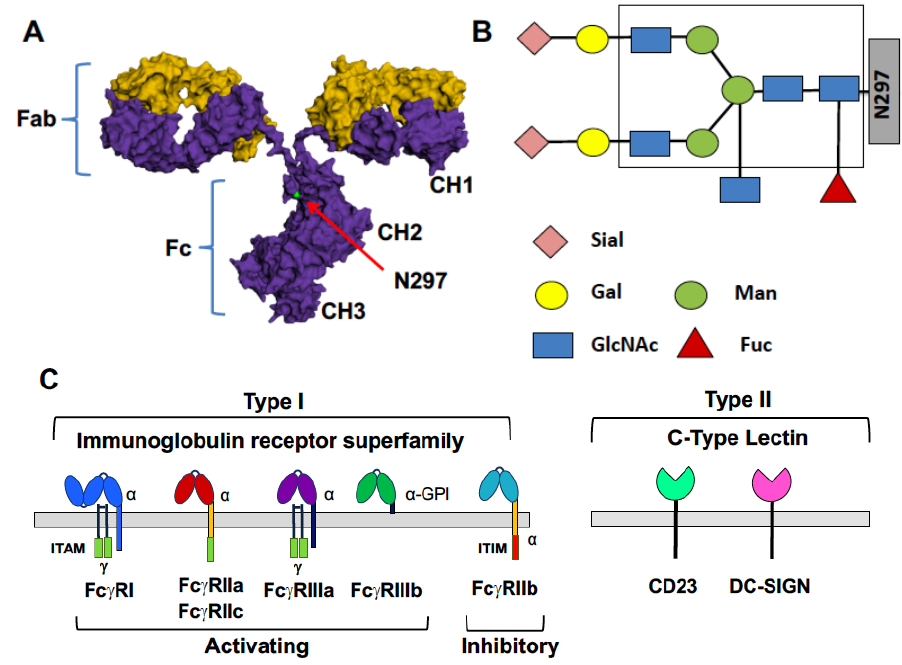
Figure 1. IgG antibodies and their receptors. ( A ) The structure of IgG molecules is composed of two identical heavy (purple) and light chains (yellow). Heavy and light chains combine to form Fab domains which bind antigen. The paired CH2 and CH3 domains of heavy chains form the IgG Fc domain. The structure of the Fc domain is dictated by IgG subclass and composition of the Fc glycan, located at N297 within the CH2; Fc structure, in turn, determines interactions with FcγRs; ( B ) Structure of the N297-linked Fc glycan. The composition of the core glycan is boxed; sialic acid (Sial), galactose (Gal), N -acetylglucosamine (GlcNAc), and fucose (Fuc) can be added to the core structure; ( C ) Type I and Type II Fc gamma receptors (FcγRs). Type I FcγRs are members of the immunoglobulin receptor superfamily; Type II FcγRs are members of the C-type lectin family.